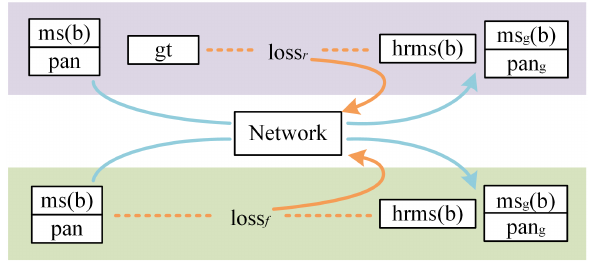
Figure 4. Training process of the proposed semi-supervised learning. The upper part is the supervised training with reduced-resolution data, the lower part is the unsupervised training with full-resolution data. The blue lines are the forward propagation while the orange lines are the backward